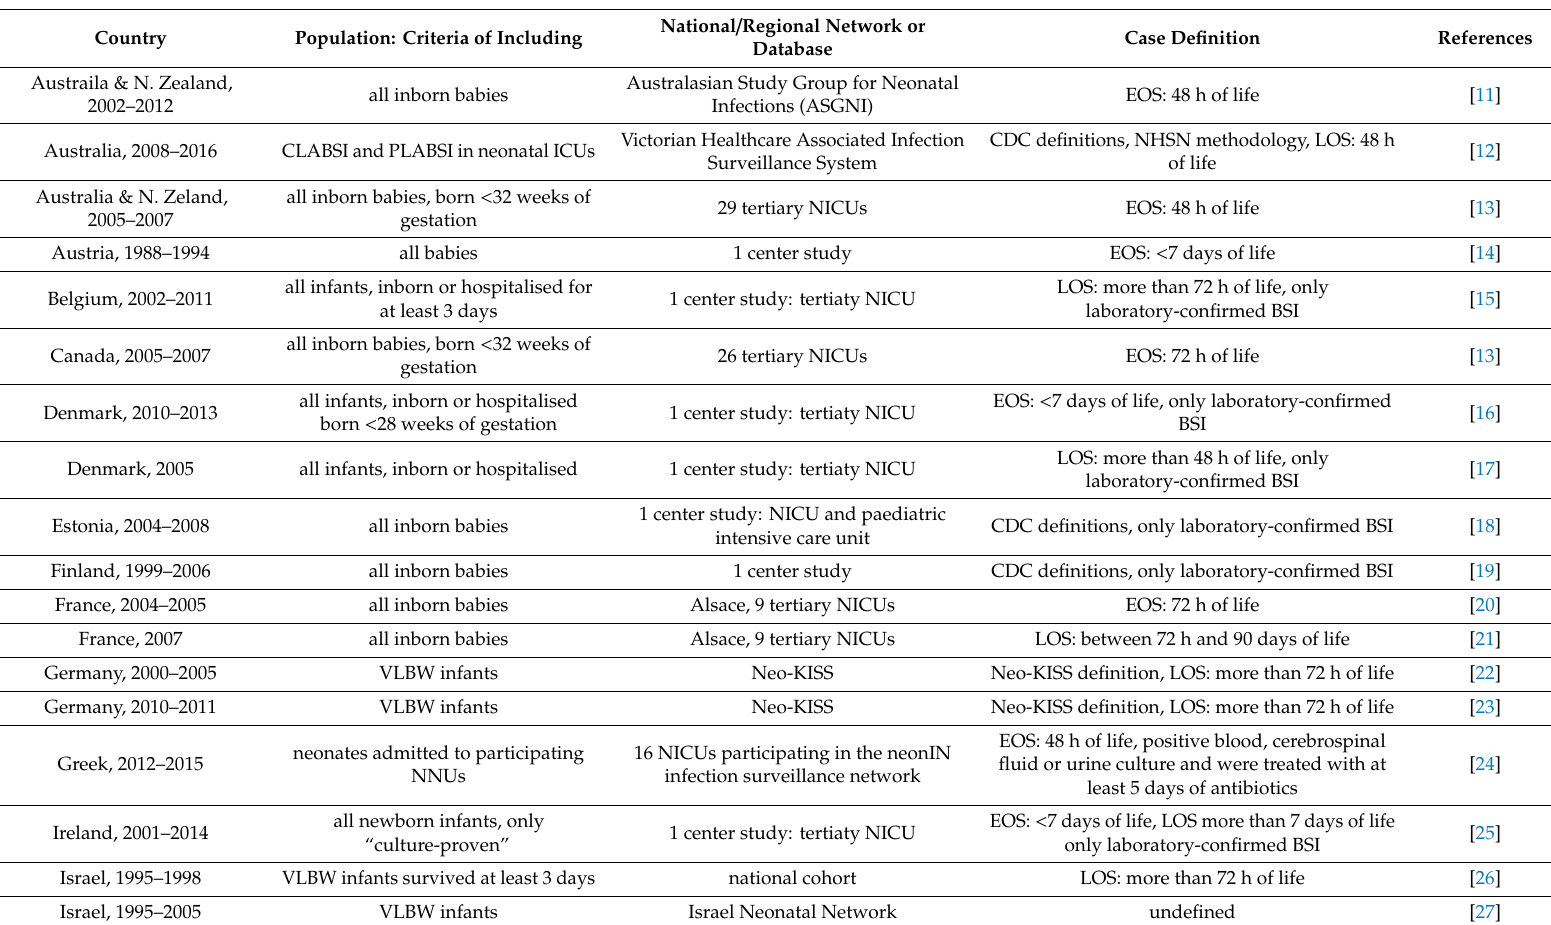
Table 1. Characteristics of the collected studies on neonatal sepsis and bloodstream infections incidence rate in Organization for Economic Cooperation and Development (OECD) countries (in alphabetical